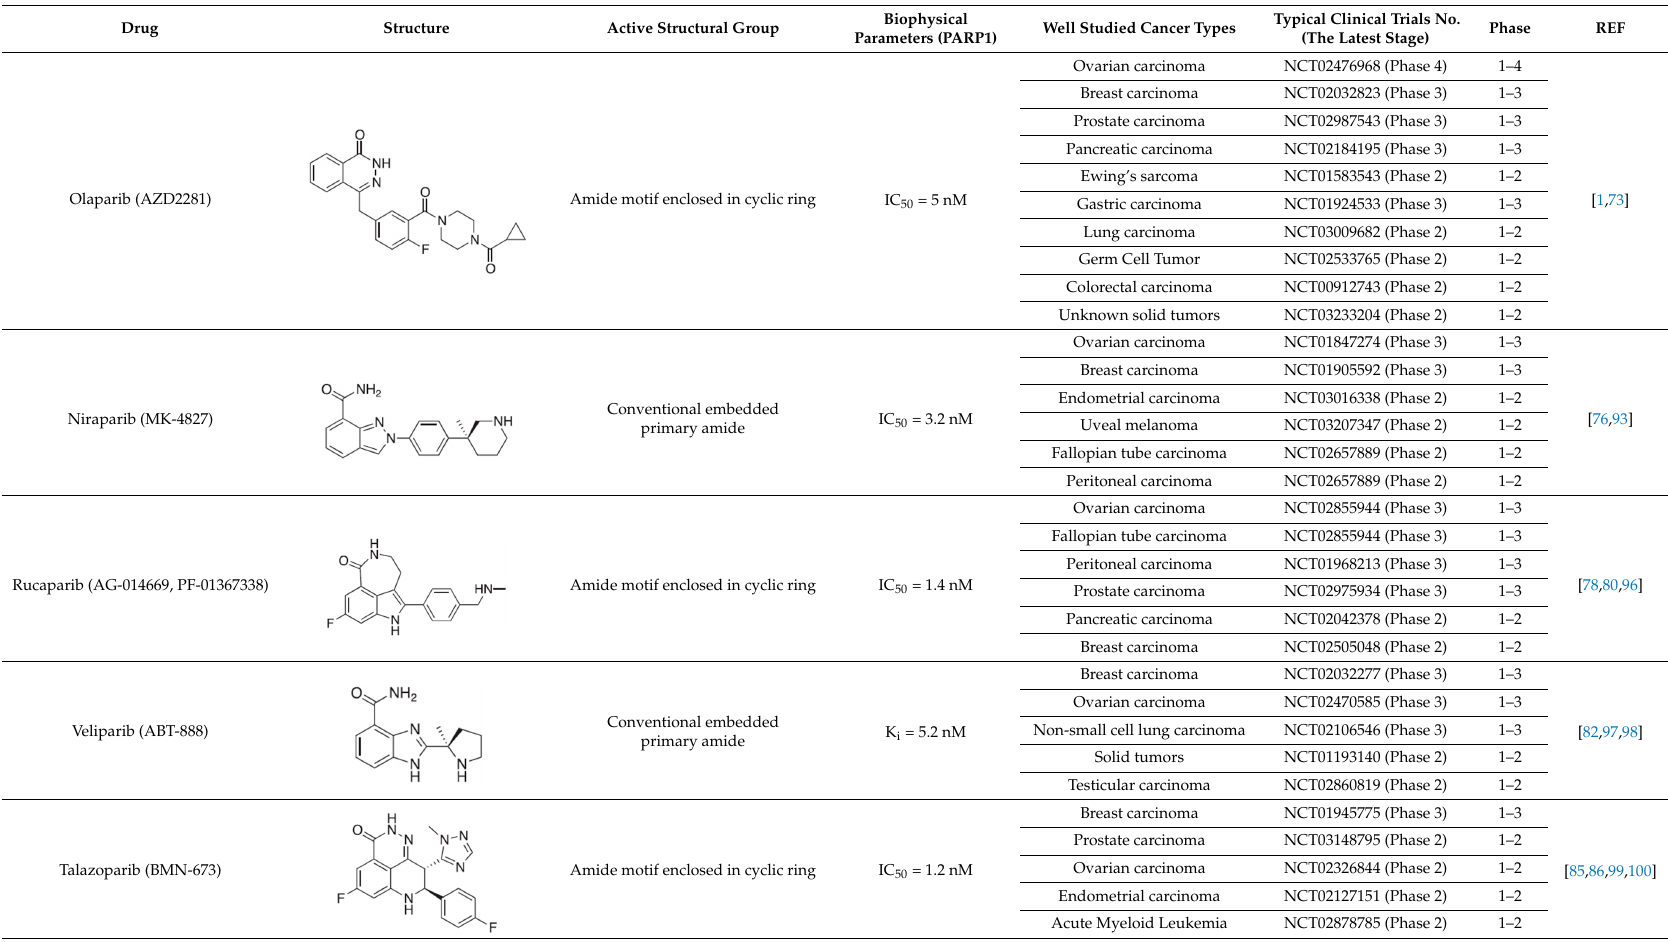
Table 2. Structure and indications of mature anticancer PARP1-based drugs entered clinical trials.